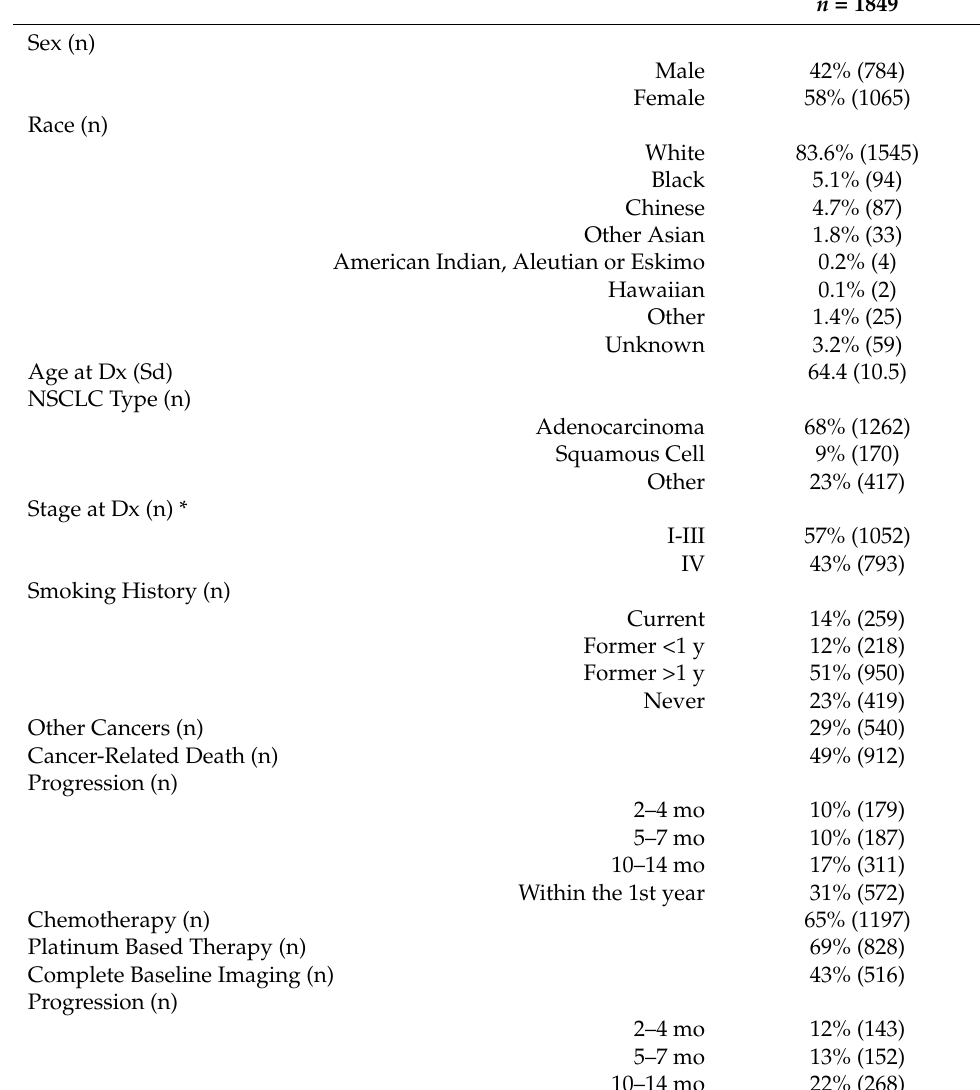
Table 1. Population